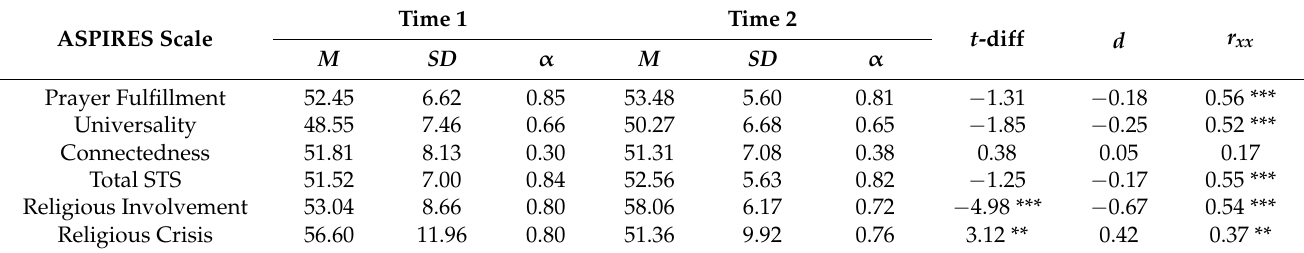
Table 2. Descriptive Statistics, Alpha Reliabilities, and Change Over Time t -tests for the ASPIRES Scales. ASPIRES